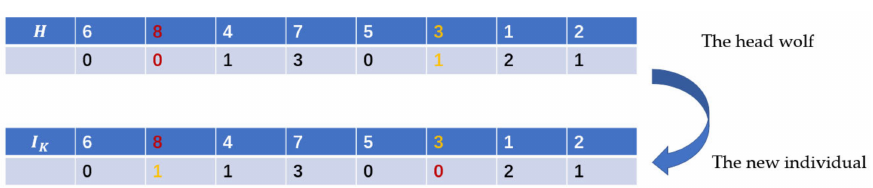
Figure 6. Create new individuals by replicating the head wolf.